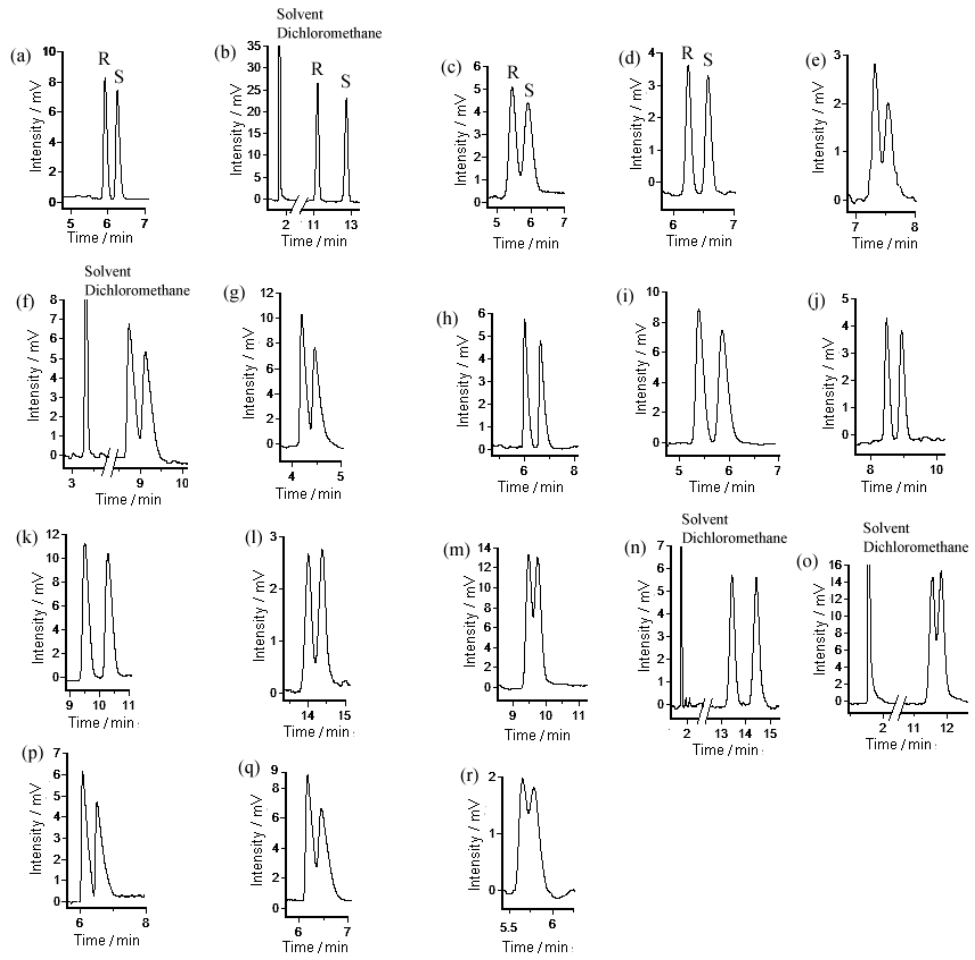
Figure 3. GC chromatograms on the pentyl cage-coated capillary column for separation of racemates: ( a ) styrene oxide; ( b ) trans-stilbene oxide, ( c ) 1,2-epoxybutane; ( d ) 1,2-epoxyhexane; ( e ) 1-bromo-2,3-